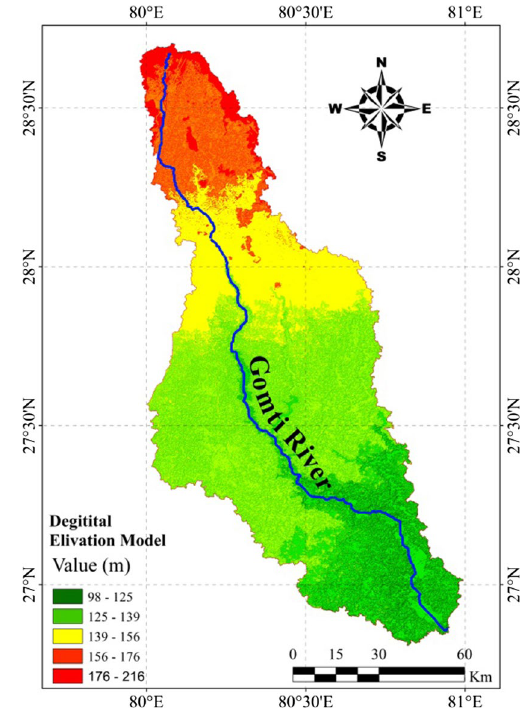
Fig. 2 Digital elevation map of the study